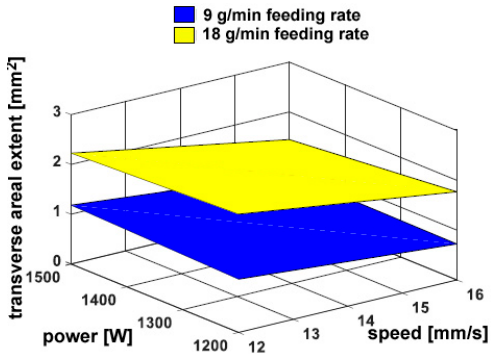
Figure 7. Transverse areal extent of reported metal A h as a function of the governing variables; flat deposition.